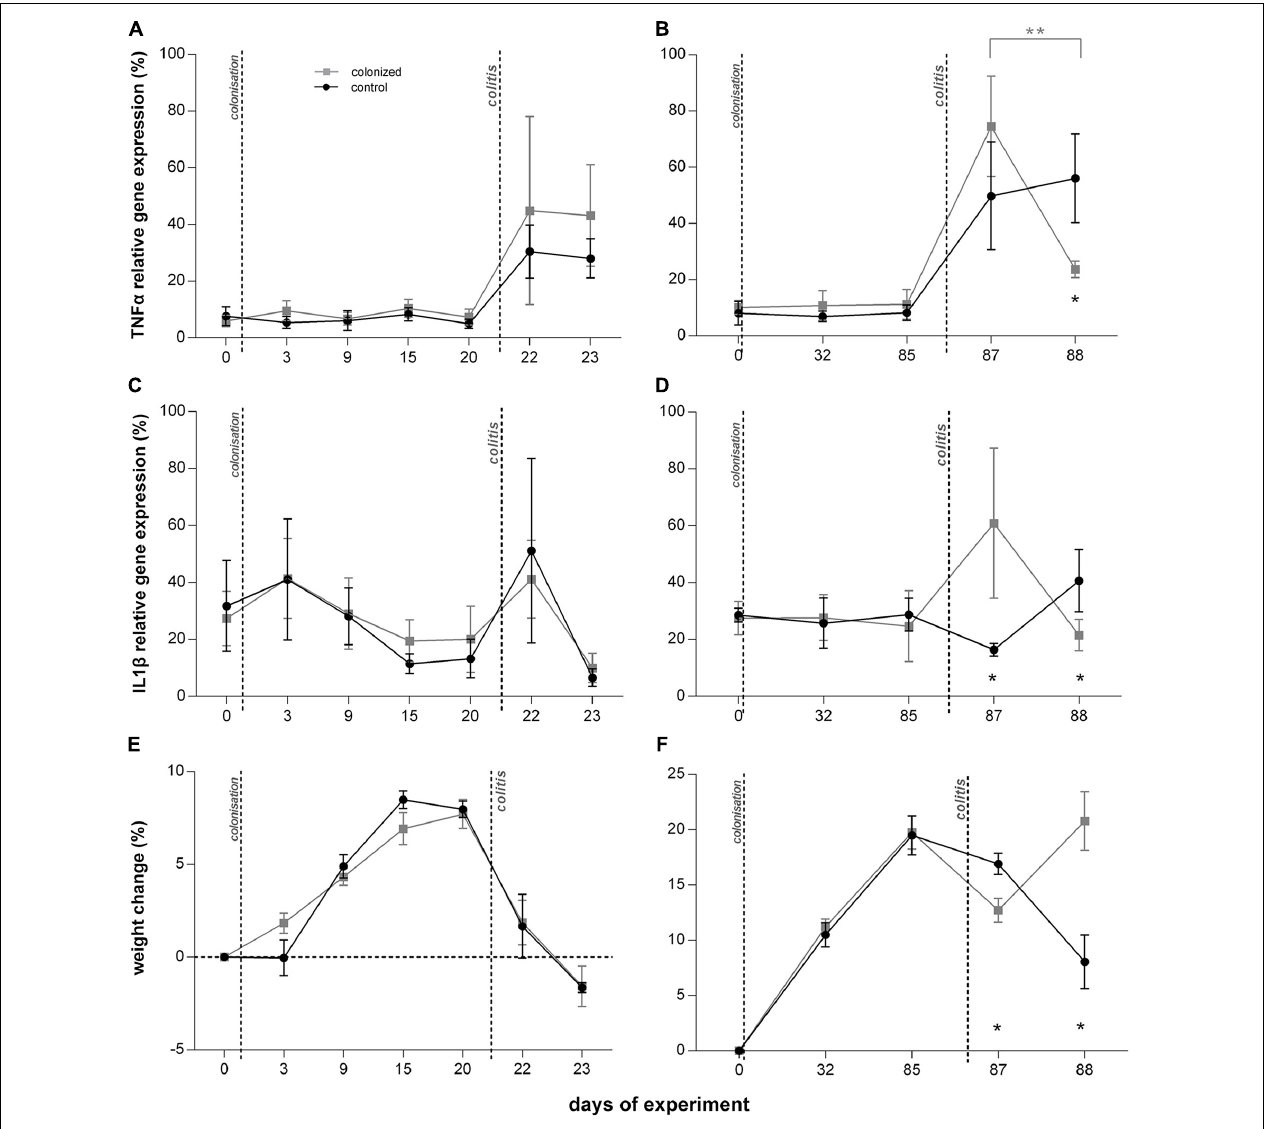
FIGURE 2 | Effect of Blastocystis ST3 on the moderate colitis in the rat model after the short-term (3 weeks; A,C,D ) and long-term (13 weeks; B,D,F ) colonization. Blastocystis -colonized group is in gray squares, control group (i.e., non-colonized rats) in black dots. (A,B) TNF α gene expression relative to UBC housekeeping gene – (A) during short-term colonization; (B) during long-term colonization; (C,D) IL1 β gene expression relative to UBC housekeeping gene – (C) during short-term colonization, and (D) during long-term colonization; (E,F) % weight changes after colitis induction (calculated by comparing at Day 0) – (E) during short-term colonization; (F) during long-term colonization. Differences between groups calculated with Welch’s t -tests followed by Benjamini–Hochberg correction. Error bars are standard errors; * P = 0.05–0.01, ** P = 0.01–0.001, *** P <